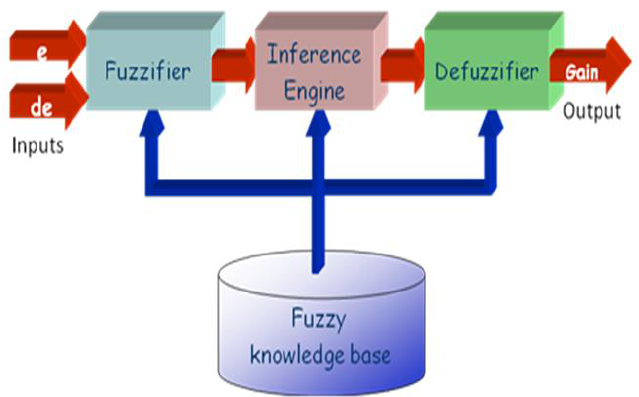
Figure 3. Inner structure of fuzzy logic